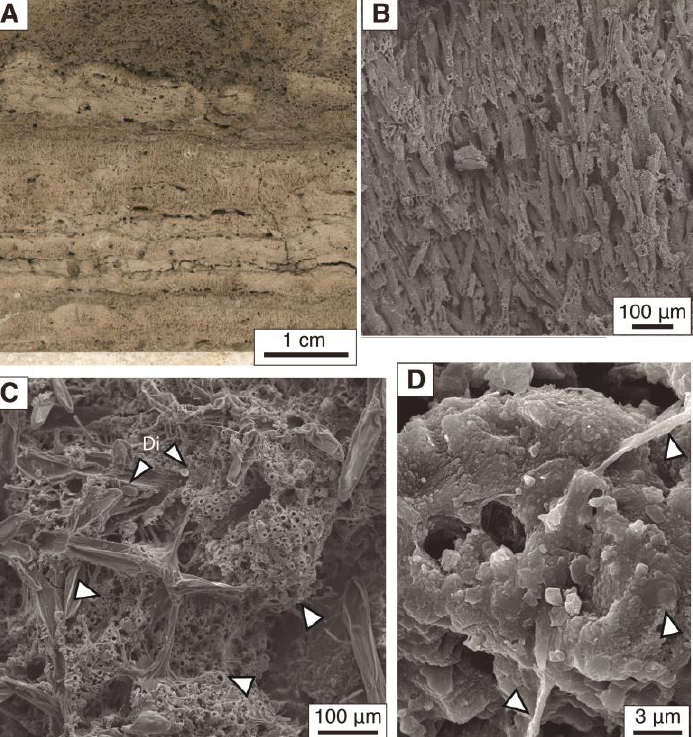
Figure 3. ( A ) Detail of lamination in cross-section of Tablet RP-16 [19] (six-month intervals as in Figure 2A); ( B ) SEM image of Tablet RP-14: palisades of calcite tubes from filamentous cyanobacteria; top is upward; ( C,D ) SEM images of Tablet M-4; ( C ) Calcite tubes (plan view) and EPS-containing diatoms. ( D ) Detail of calcite tubes and EPS (arrows) .